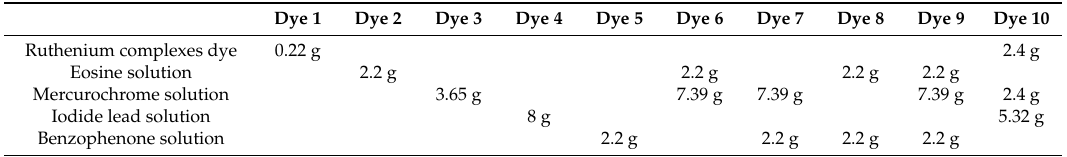
Figure 5. Change in photocurrent density and piezoresistive resistance under visible and ultraviolet light versus the amount of Al 2 O 3 and TiO 2 for wet-type MCF rubber solar cell electrolytically polymerized under a magnetic field with ruthenium complex dye and KI + I 2 electrolyte. The right ordinate in the figure presents the specific resistance at non-irradiation.